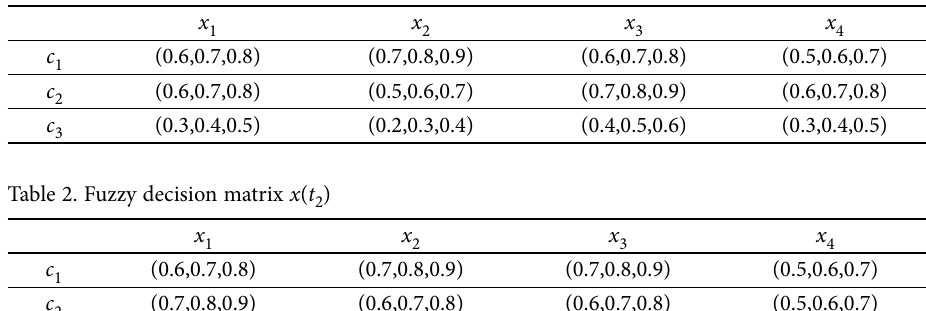
Table 1. Fuzzy decision matrix x ( t